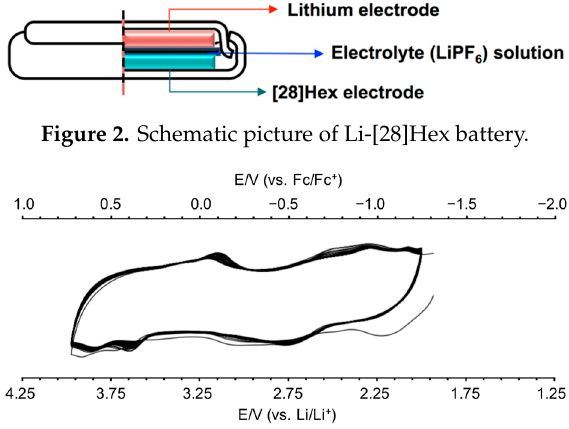
Figure 3. Cyclic voltammogram of Li-[28]hex battery.